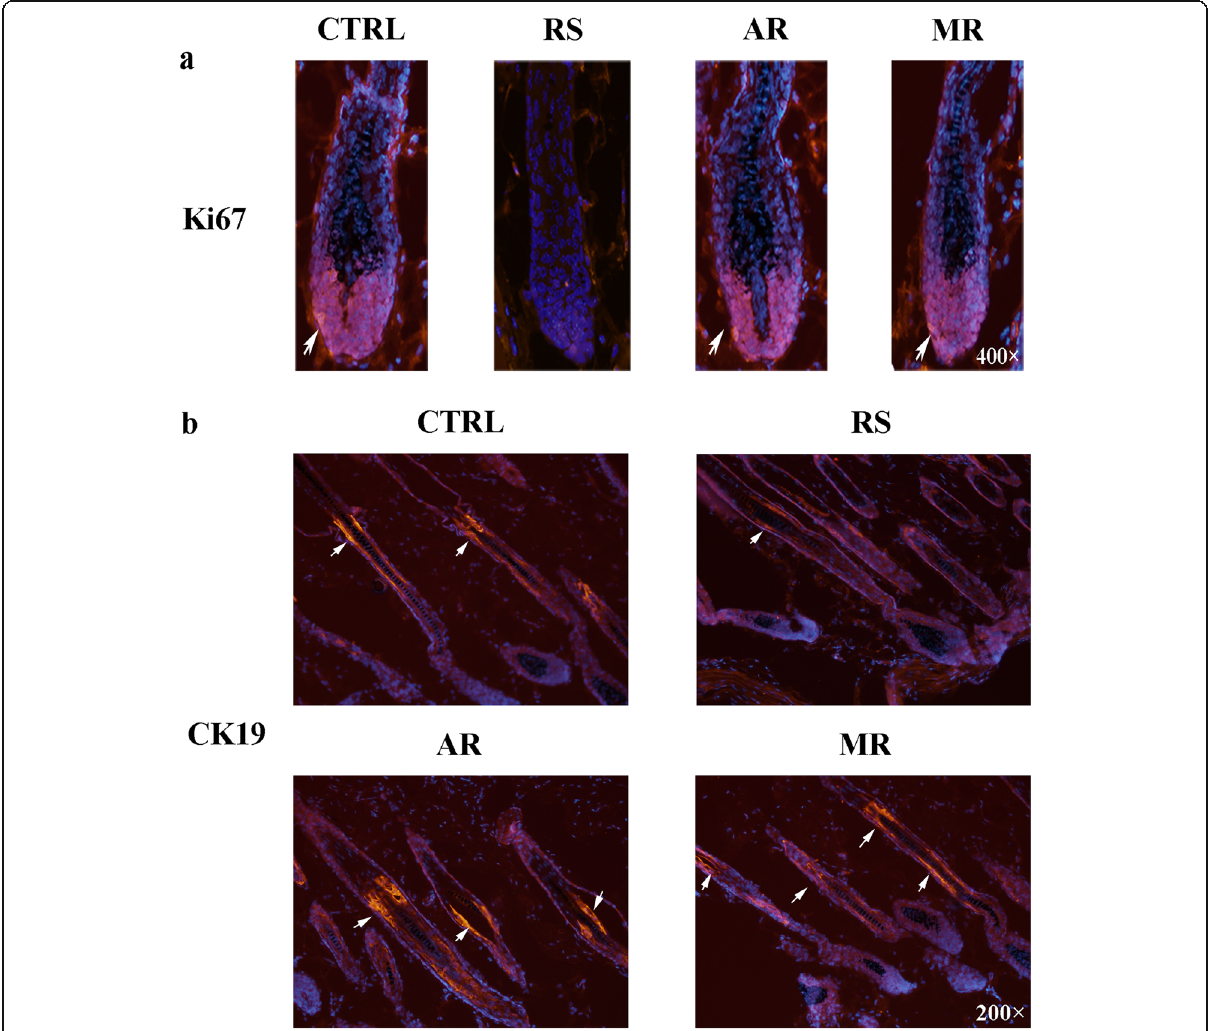
Fig. 3 Effects of AVE on Ki67 + kertinocytes and cytokeratin19 (CK19) + stem cells proliferation. The expressions of Ki67 + kertinocytes (red staining, pointed out by arrows) ( a ) and CK19 + stem cells (red staining, pointed out by arrows) ( b ) in the hair follicles of C57BL/6 mice were visualized by immunofluorescence. Magnification: ( a ) 400×; ( b ) 200×. Negative controls did not reveal specific